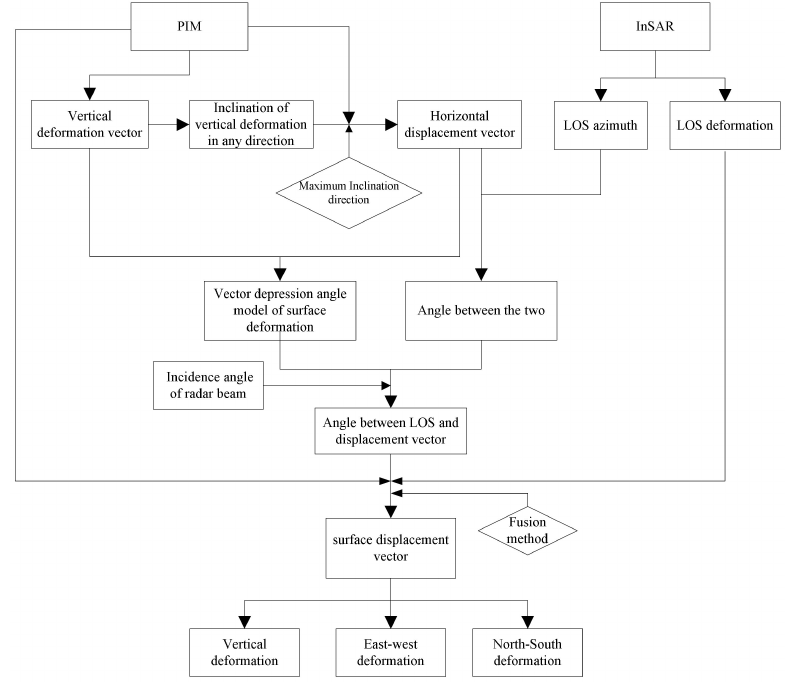
Figure 3. Technical process.